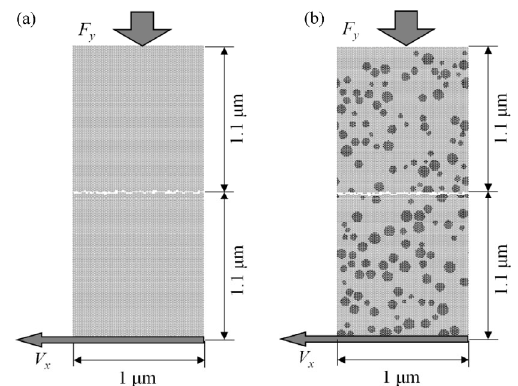
Fig. 12 Schematics of Y-TZP (a) and Y-TZP-20%Al 2 O 3 (b) for the model samples and